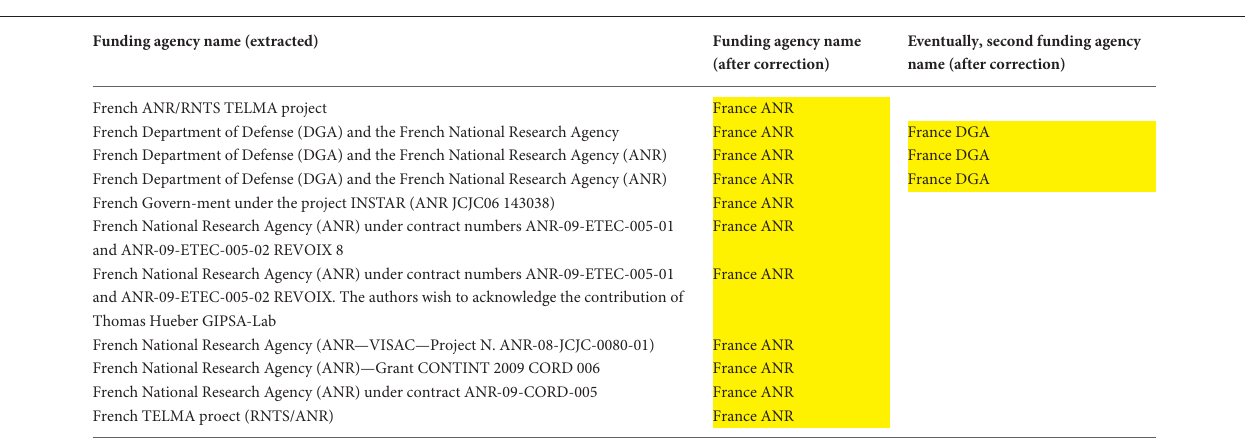
FIGURE 11 | Example of cleaning cited Funding Agencies: the case of the French ANR.